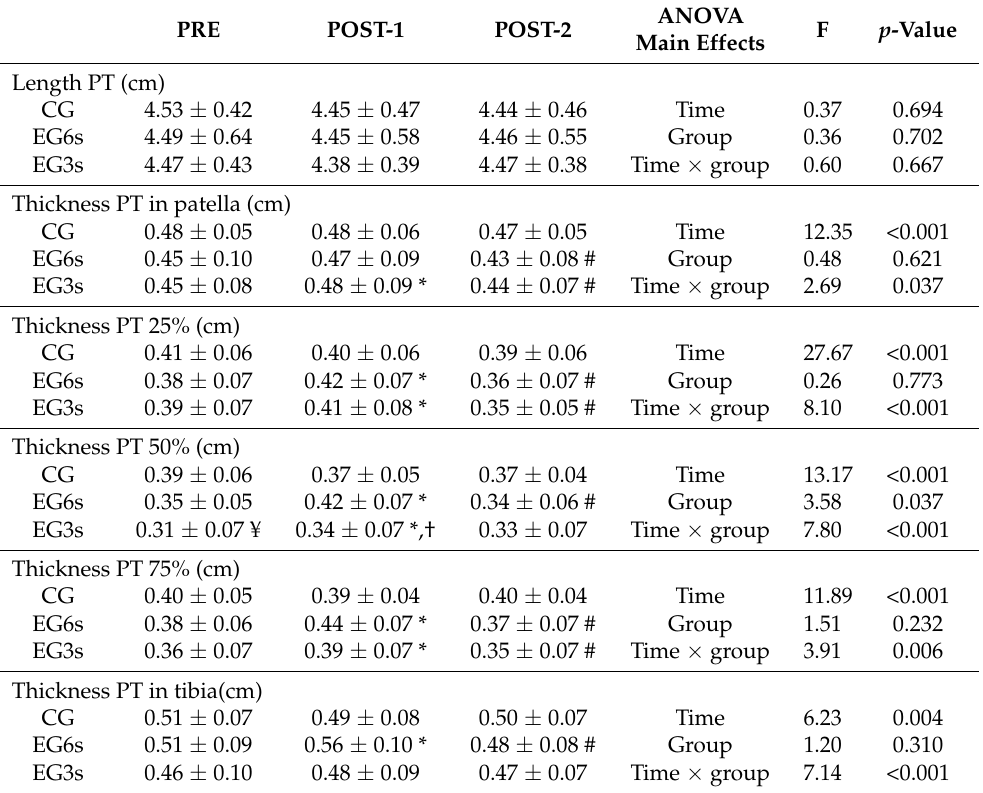
Table 1. Morphological properties of the PT in response to six weeks of eccentric training (POST-1) with two execution runtimes (EG6s = 6 s and EG3s = 3 s) and a 6 week follow up of detraining (POST-2). PRE